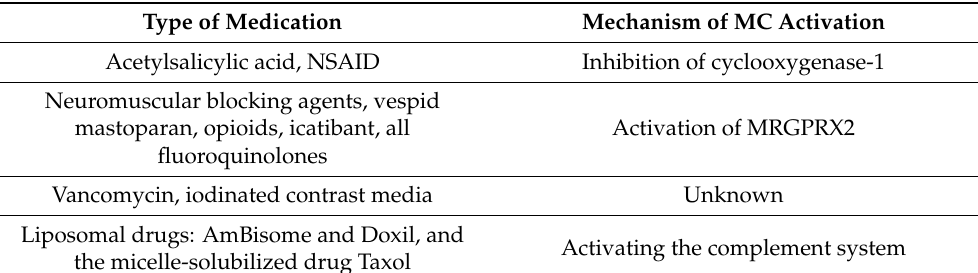
Table 2. Mechanisms of MC activation by medication [92]. Type of